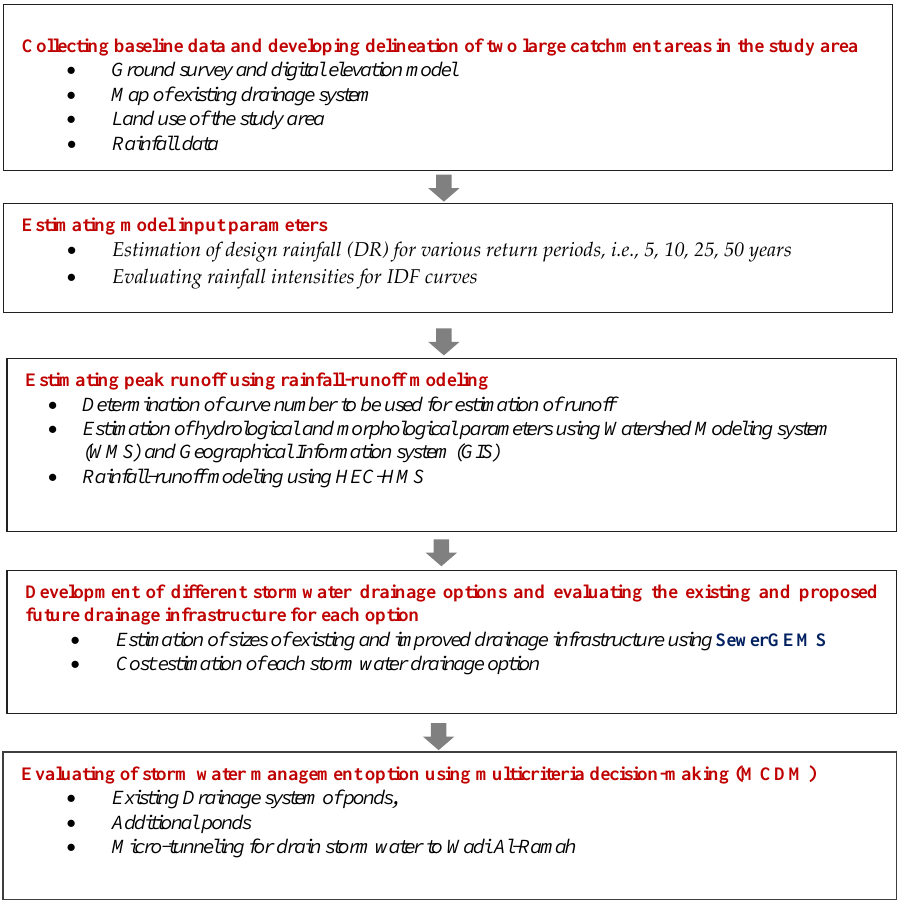
Figure 2. Methodological framework for evaluating storm water drainage options in arid